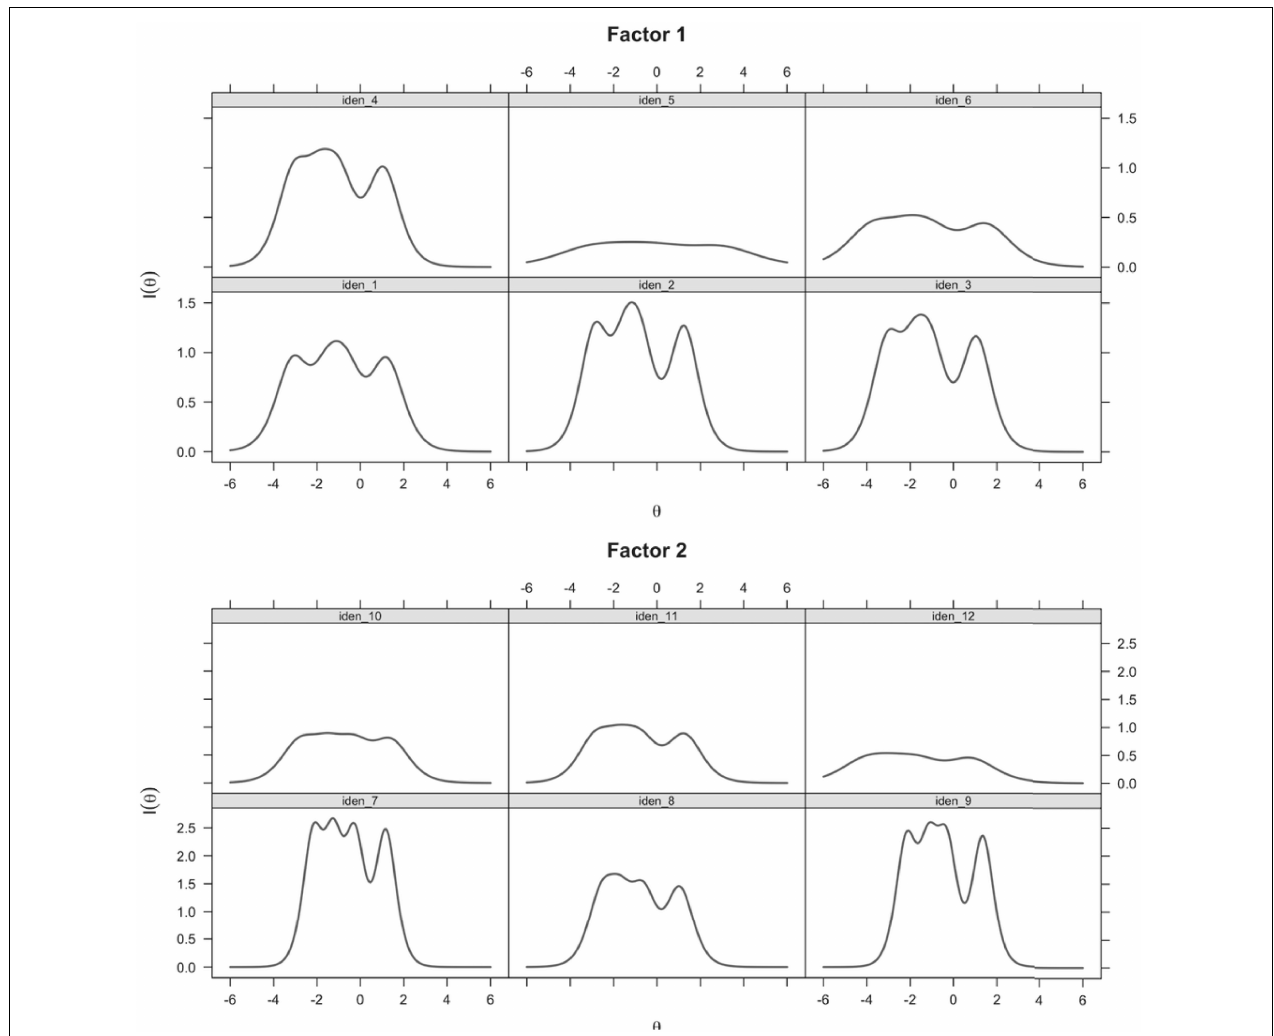
FIGURE 1 | Item information curves for the Doctoral Student Identity